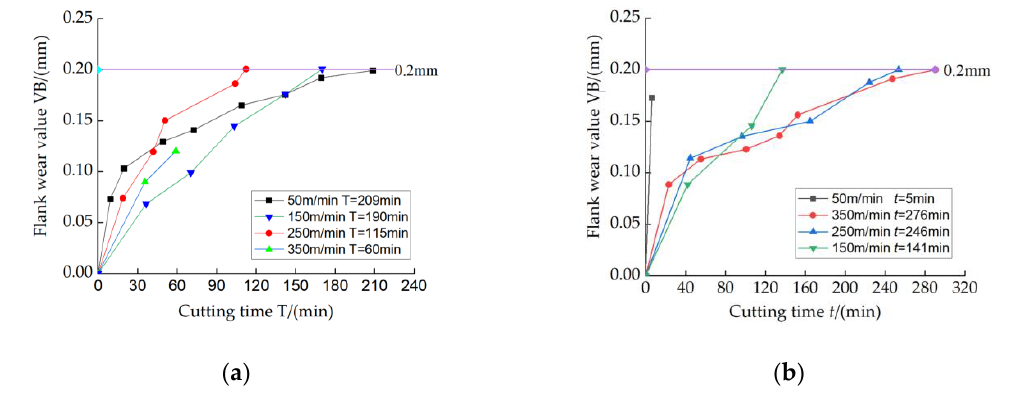
Figure 5. Influence of cutting speed on tool wear: ( a ) Tool wear of cemented carbide tools (BNM 200); ( b ) Tool wear of polycrystalline cubic boron nitride (PCBN) cutting tools (BN